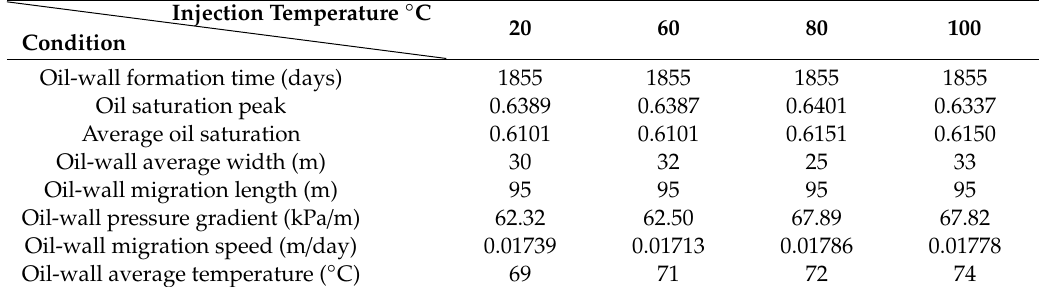
Table 9. Characteristic parameters of oil-wall under di ff erent air injection temperatures.